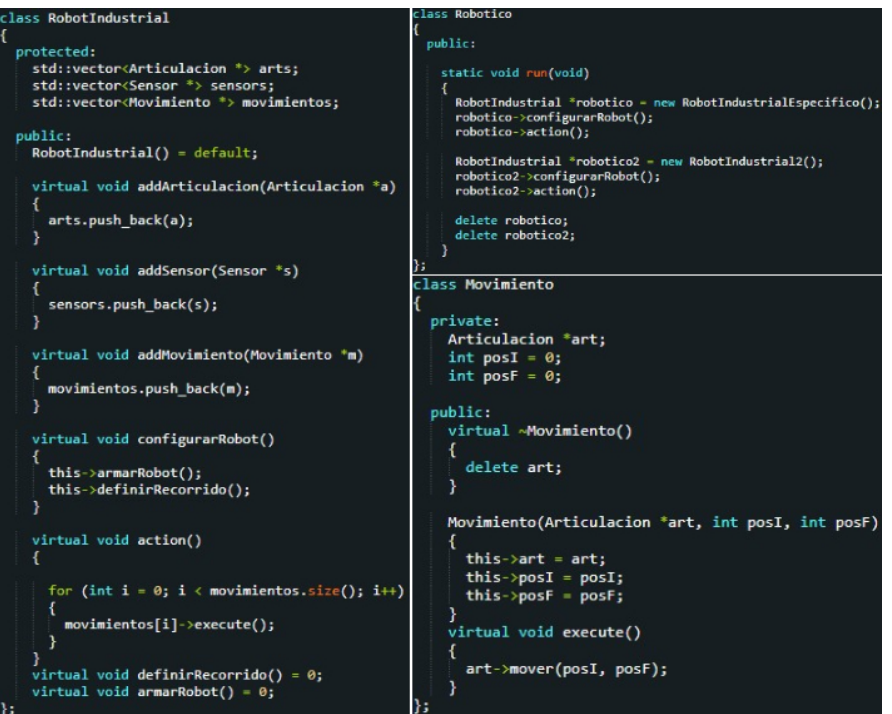
Figure 4. Snippets of source code in the framework developed for industrial robots with Arduino as part of